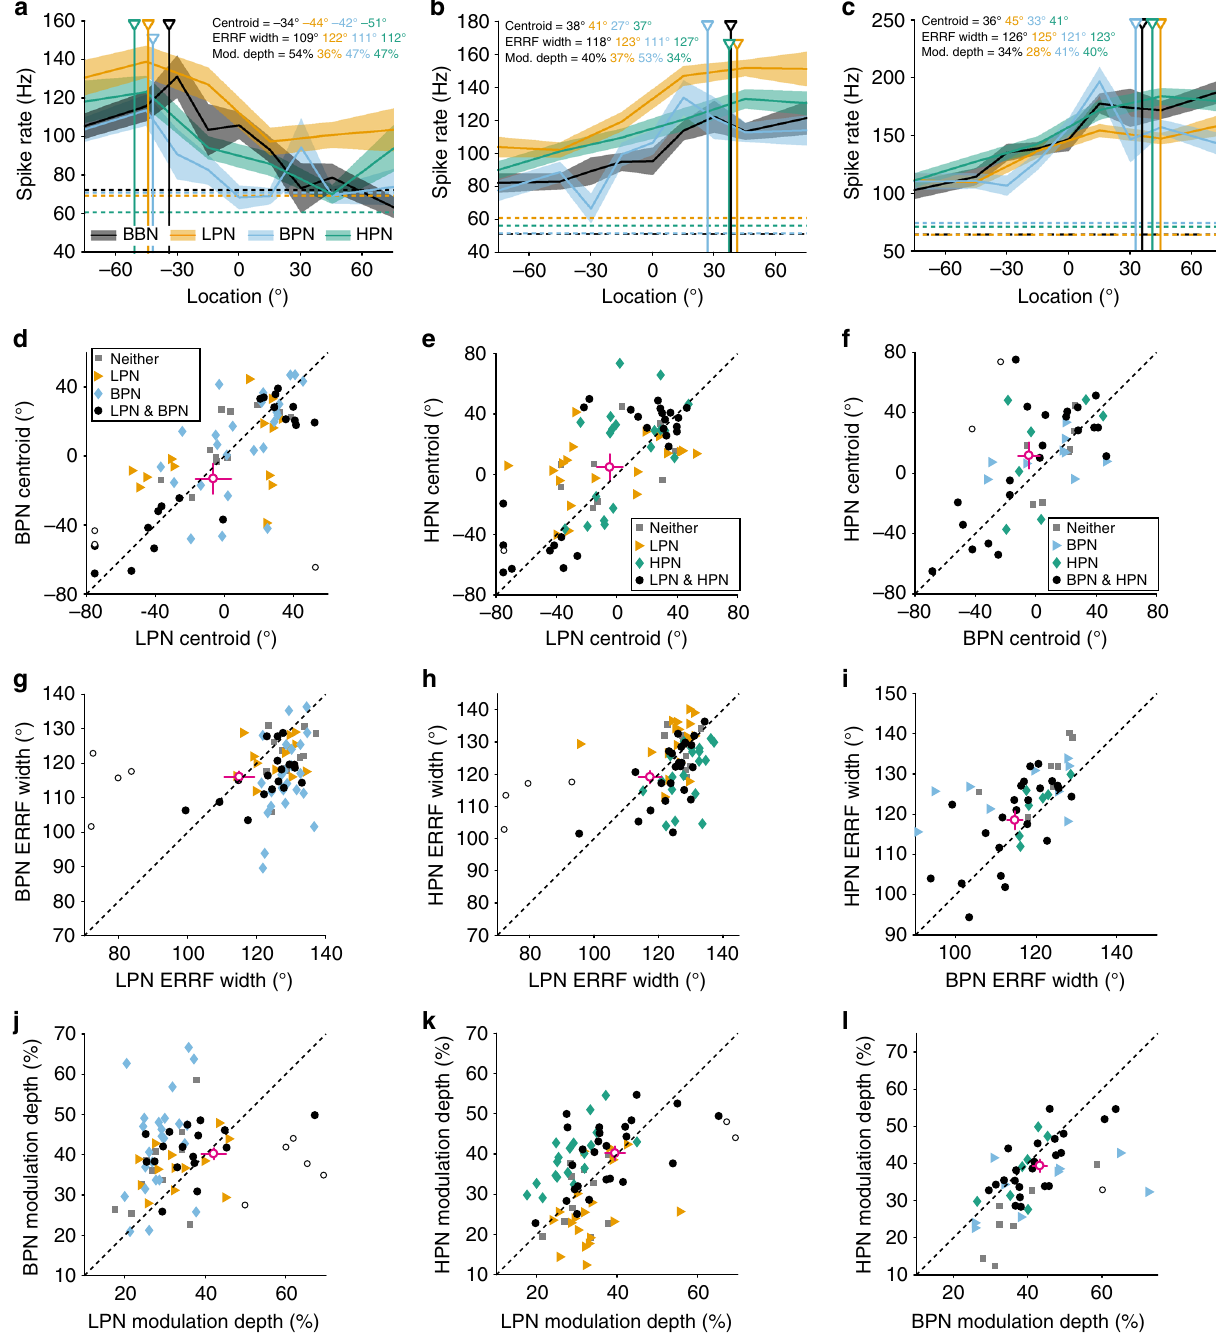
Fig. 4 Comparison of spatial tuning properties between cue-restricted stimuli. a – c shows three example units recorded in all four cue conditions: broadband (BBN, grey), low-pass (LPN, orange), bandpass (BPN, blue) and high-pass (HPN, green). Centroid, ERRF width and modulation depth in each condition are indicated. The dotted lines represent the spontaneous fi ring rate. For panels d – l , units that were spatially tuned in both conditions (circles), either condition alone (diamonds or triangles) or tuned in neither (squares). Open circles indicate individual units that signi fi cantly changed between stimuli (non-parametric resampling, see Methods). Mean± s.e.m. of the units spatially modulated in both conditions (i.e., of the black circles) is shown by cross-hairs (circle, magenta). d – f Centroids, ERRF width ( g – i ) and modulation depth ( j – l ) of units recorded in both LPN and BPN conditions ( d , g , j ; both spatially tuned N = 22, LPN tuned = 13, BPN tuned = 24, neither tuned = 11), LPN and HPN conditions ( e , h , k ; both spatially tuned N = 27, LPN tuned = 19, HPN tuned = 19, neither tuned = 10) and BPN and HPN conditions ( f , i , l ; both spatially tuned N = 23, BPN tuned = 9, HPN tuned = 7, neither tuned =